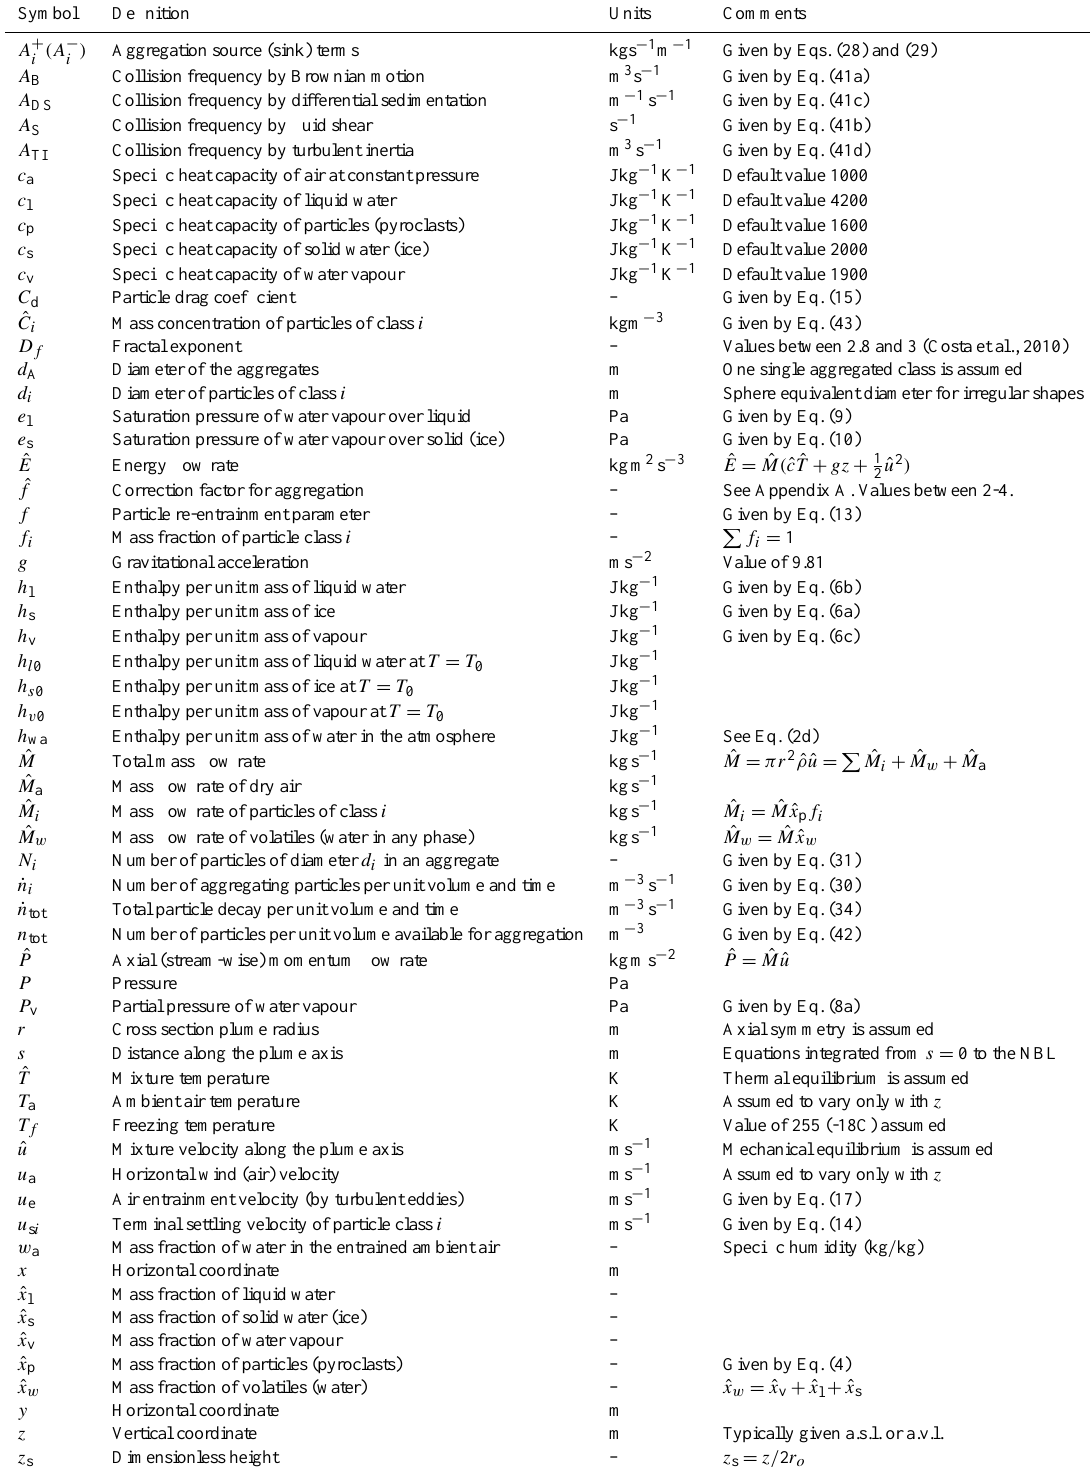
Table 1. List of Latin symbols. Quantities with a hat denote bulk (top-hat averaged) quantities. Throughout the text, the subindex o (e.g. ˆ M o , ˆ u o ) indicates values of quantities at the vent ( s =